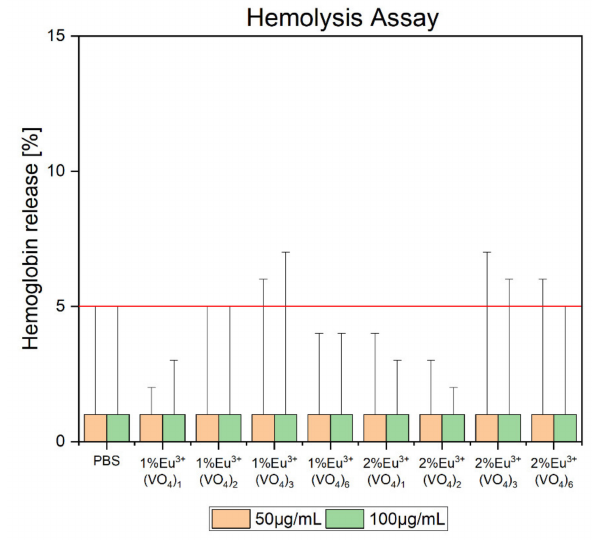
Figure 8. Hemolysis of selected compounds from the first series: Ca 9.9 Eu 0.1 (PO 4 ) 6 − x (VO 4 ) x (OH) 2 , and second series: Ca 9.8 Eu 0.2 (PO 4 ) 6 − x (VO 4 ) x (OH) 2 , where x = 1, 2, 3, 6. The concentration of the tested compounds was estimated at 50 µ g/mL and 100 µ g/mL. The red line was equal to 5% of acceptable hemoglobin release. The results were compared with red blood cells treated with PBS buffer (1% of hemolysis—negative control) and 1% SDS (100% of hemolysis—positive control).